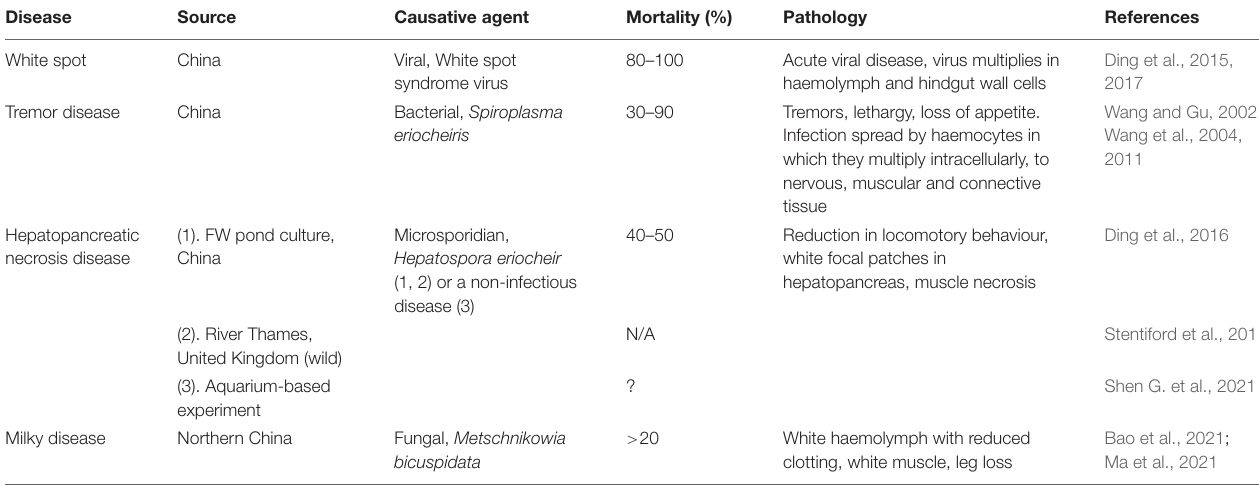
TABLE 1 | Key diseases of Chinese mitten crabs, Eriocheir sinensis in